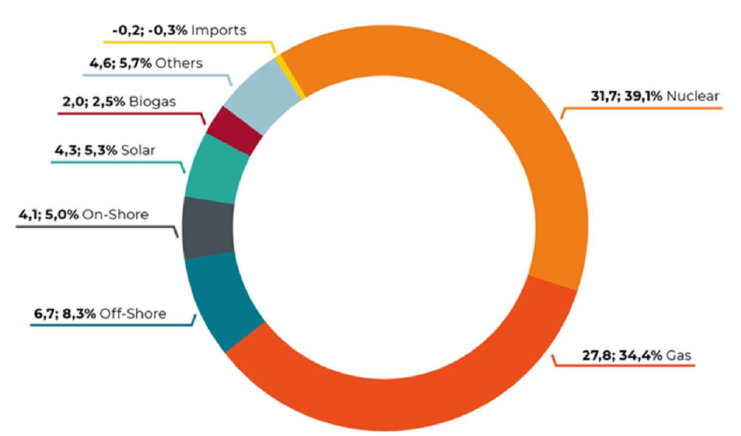
Figure 18. Electricity generation mix in 2020 in Belgium [157].